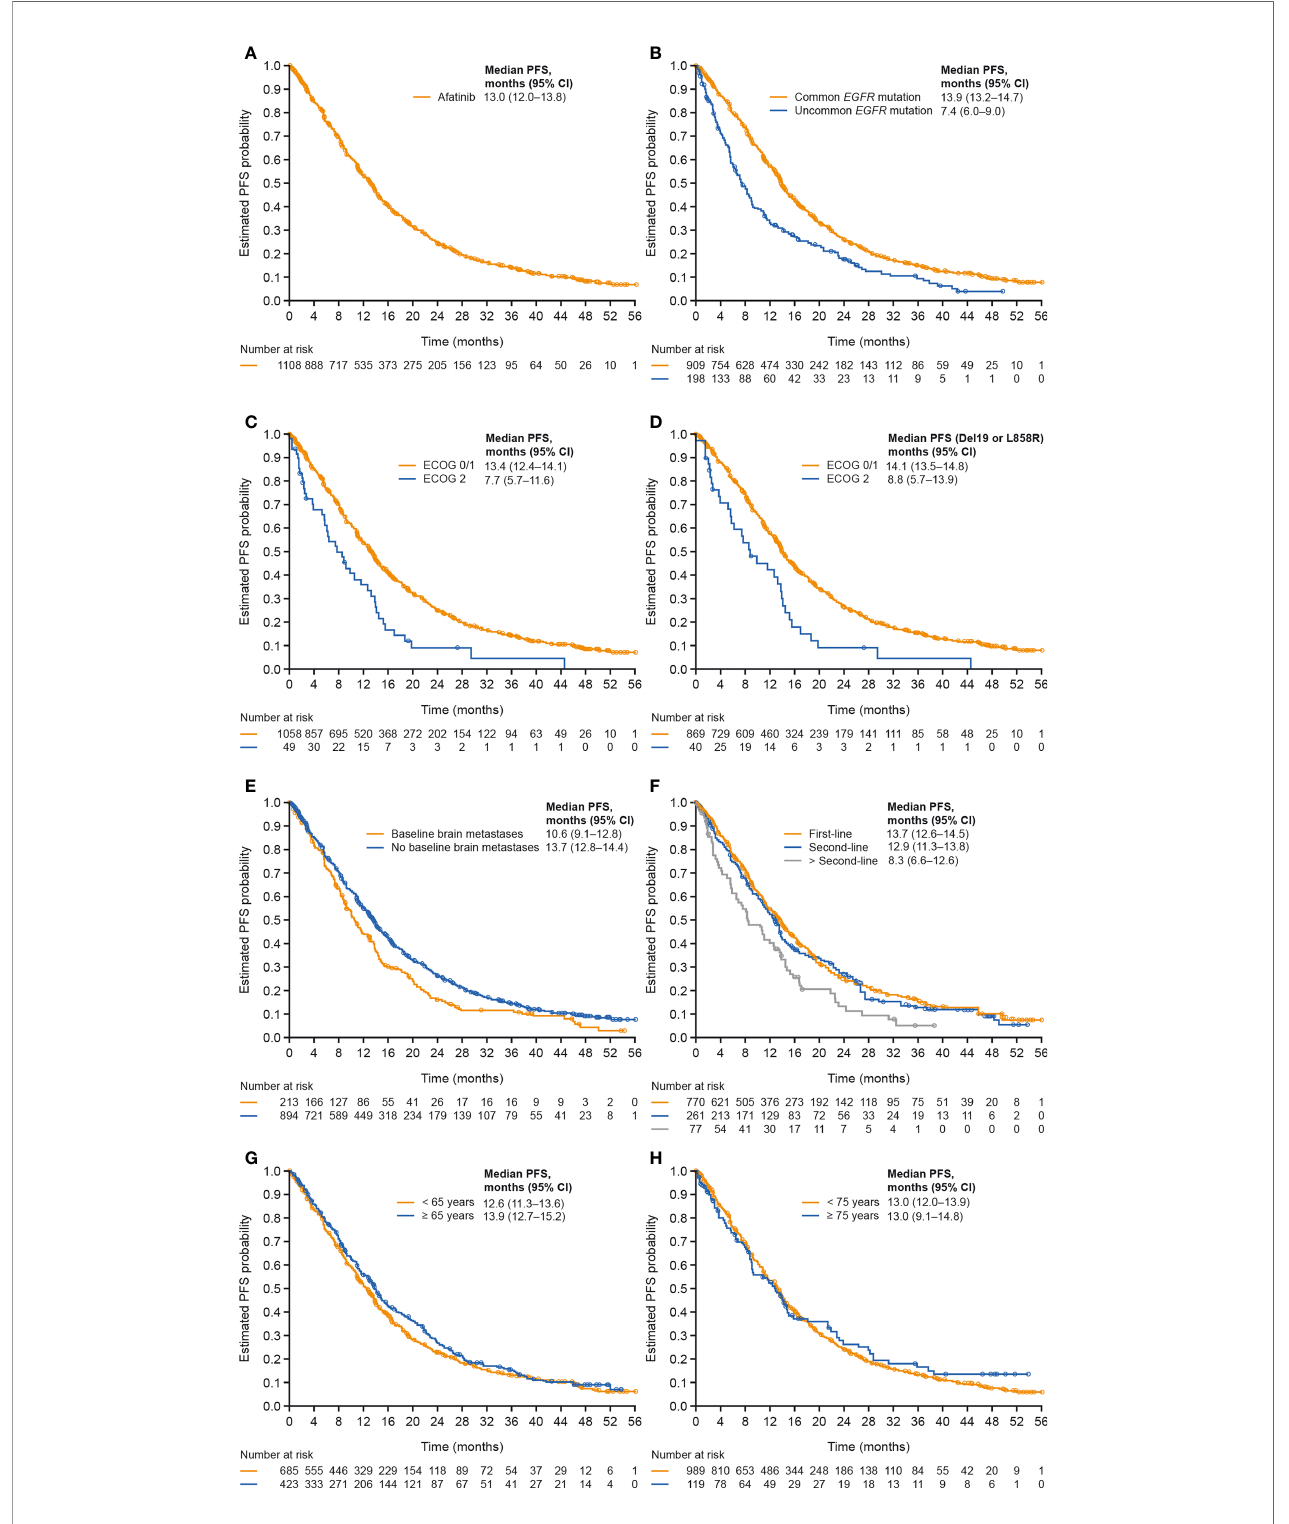
FIGURE 1 | PFS in (A) all patients, (B) patients with tumors harboring common versus uncommon mutations, (C) patients with ECOG PS 0/1 versus 2, (D) patients with common mutations and ECOG PS 0/1 versus 2, (E) patients with versus without baseline brain metastases, (F) patients treated with afatinib in fi rst, second and later lines of therapy, (G) patients aged <65 or ≥ 65 years, and (H) patients aged <75 or ≥ 75 years. CI, con fi dence interval; ECOG PS, Eastern Cooperative Oncology Group performance status; PFS, progression-free